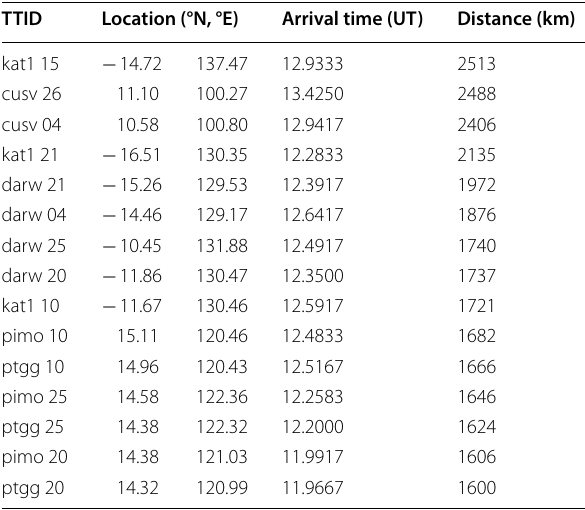
Table 1 Locations and propagations of